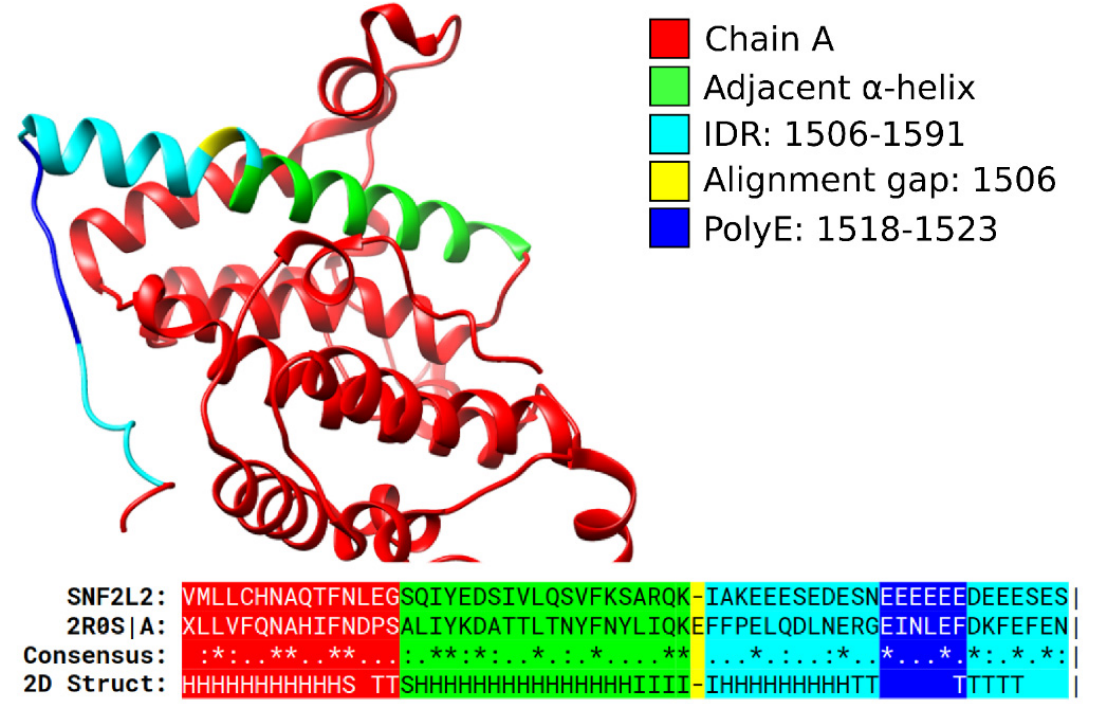
Figure 4. A polyE in SNF2L2 aligns to a coil region in yeast RSC4 . Structure of the yeast protein RSC4 (PDB:2R0S). Human protein SNF2L2 (UniProt: P51531) with a polyE (blue) inside a predicted